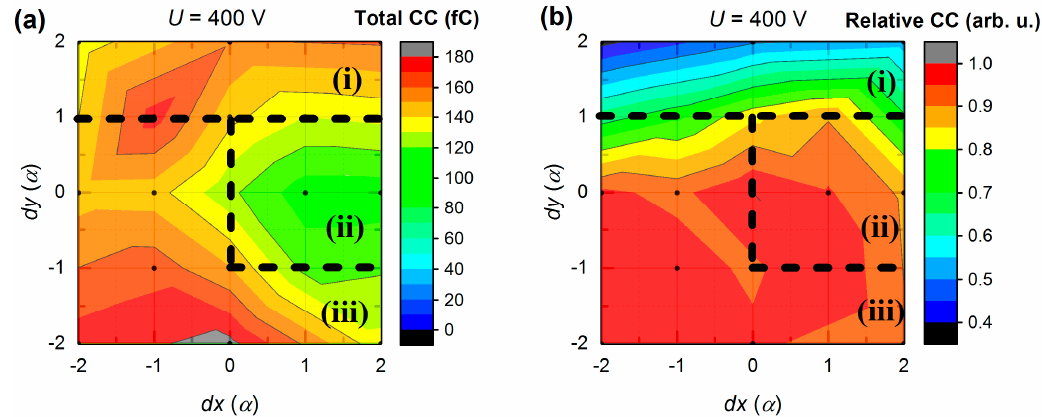
Figure 12. Dependence of ( a ) total CC and ( b ) relative CC on illumination position at 400 V bias ( α = 0.85 mm).